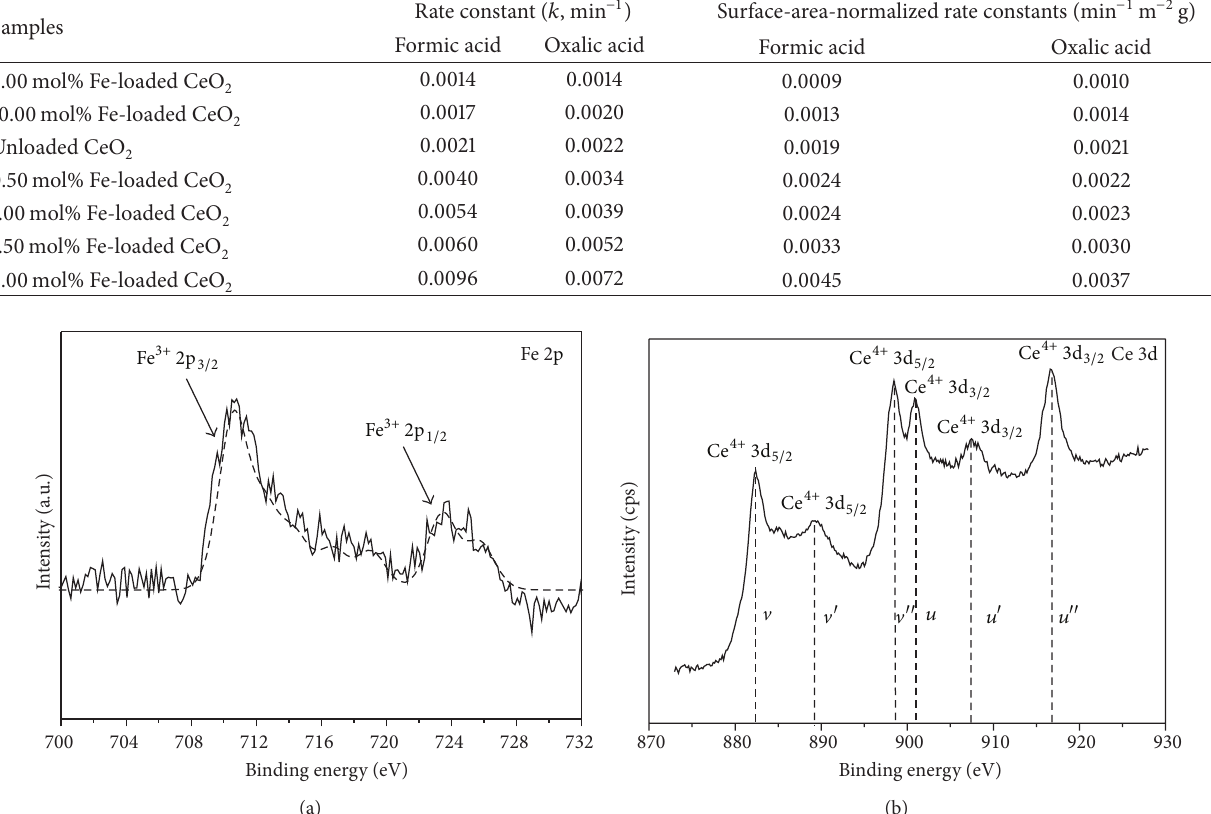
Table 3: Apparent rate constants and surface-area-normalized rate constants.